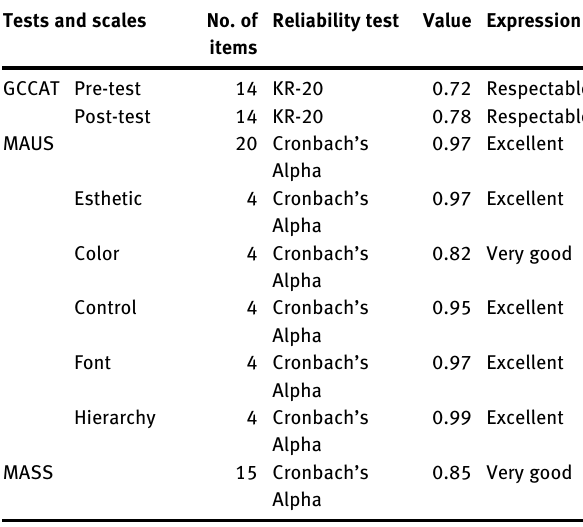
Table  : Reliability values of tests and scales. Tests and